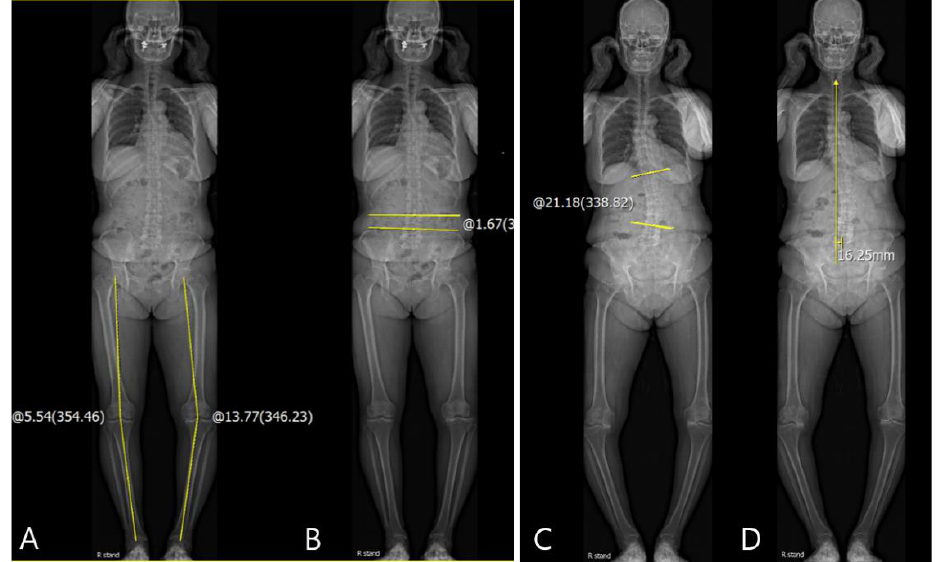
Figure 1. ( A ) Measurement of coronal HKA angle: coronal HKA Rt-Lt = −8.23°; ( B ) measurement of of pelvic obliquity: − 1.67 ◦ ; ( C ) measurement of the scoliosis angle: +21.18 ◦ ; ( D ) measurement of pelvic obliquity: −1.67°; ( C ) measurement of the scoliosis angle: +21.18°; ( D ) measurement of coronal coronal SVA: +16.25 SVA: +16.25 mm.